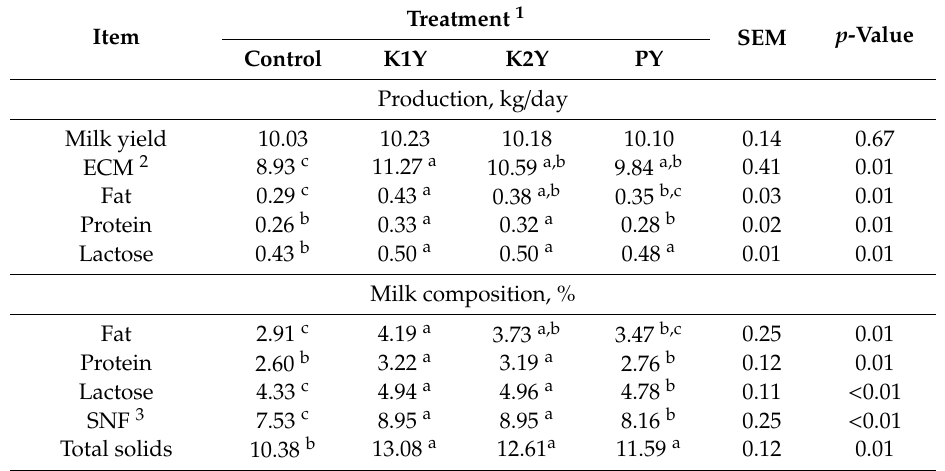
Table 4. Milk yield and milk composition of cows fed TMR supplemented with aflatoxin-detoxifying yeast.